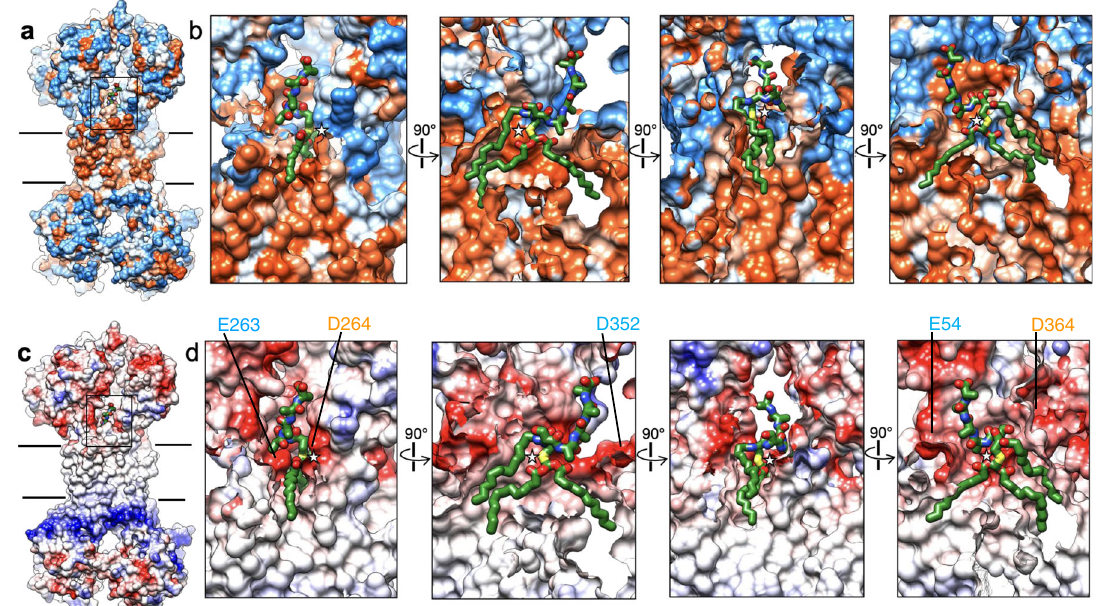
Fig. 3 Hydrophobic and electrostatic surface properties of lipoprotein binding site. a Hydrophobic surface representation of LolCDE, showing hydrophobic (orange) and hydrophilic (blue) areas. b Close-up sectional views from 4 orthogonal angles of the area indicated in ( a ). c Electrostatic surface representation of LolCDE, showing areas of positive (blue) and negative (red) charge. d Close-up sectional views from 4 orthogonal angles of the area indicated in ( c ). Lipoprotein is shown as green stick. The cysteine residue at + 1 position is marked with a star. Negatively charged residues near the lipoprotein are indicated.